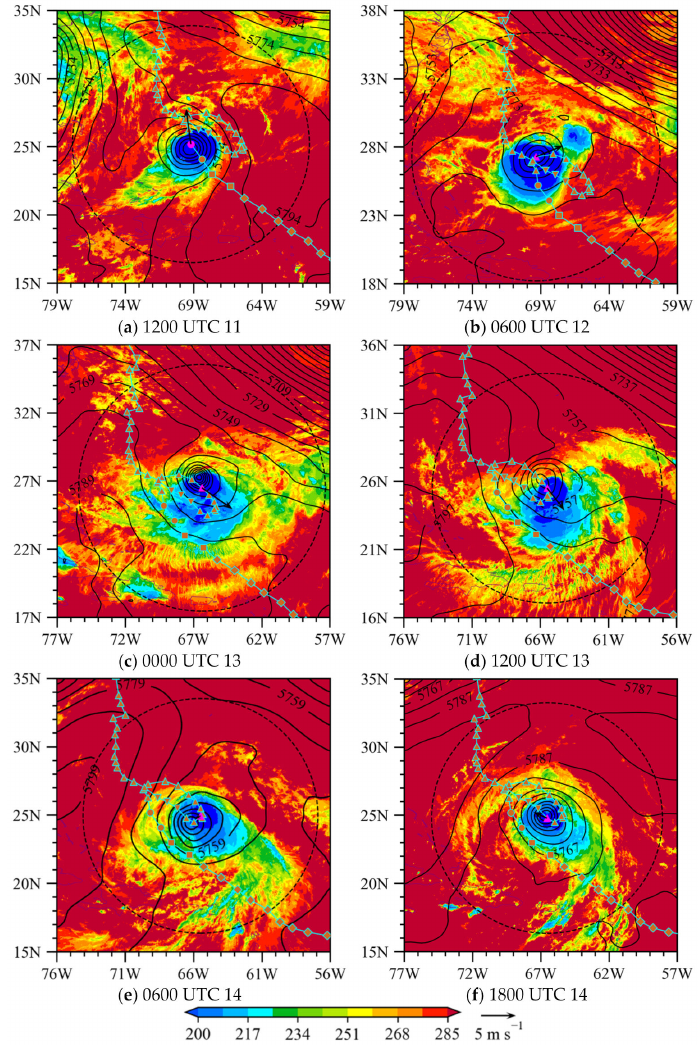
Figure 11. Spatial distributions of ABI channel 13-TB observations (color shading; unit: K) and ERA5 geopotential height (contour; unit: m) at 500 hPa at ( a ) 1200 UTC 11, ( b ) 0600 UTC 12, ( c ) 0000 and ( d ) 1200 UTC 13, ( e ) 0600 and ( f ) 1800 UTC September 14, 2017. Also shown are the ABI-determined track (cyan curve with solid markers indicating hurricane intensity) of Hurricane Jose, as well as the ABI-determined center (magenta solid marker), R OR (dashed black circle), and the steering flow (black arrow, the length of 5 m s − 1 ) at the same time as TB